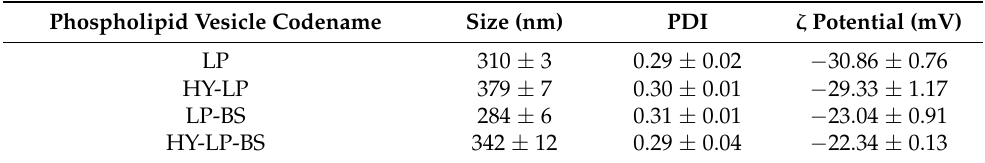
Table 1. Size (nm), particle size distribution (PDI) and ζ potential (mV) of the different phospho- lipid